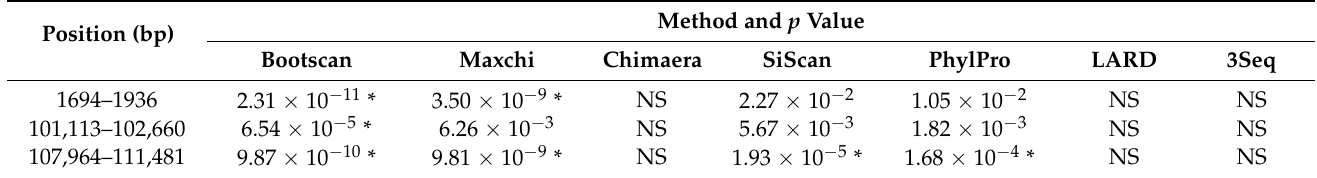
Figure 4. Phylogenetic analysis based on nucleotide sequences of PRV virulence-related and immunogenicity genes: ( A ) gB, ( B ) gC, ( C ) gD, ( D ) gG, ( E ) gH, ( F ) gL, ( G ) gM, ( H ) gN, ( I ) TK, ( J ) gI, ( K ) gE and ( L ) PK. The tree was constructed with the same method described in Figure 3. Table 5. Analysis of PRV FJ recombination events with different algorithms; the numbers represent the p value of each